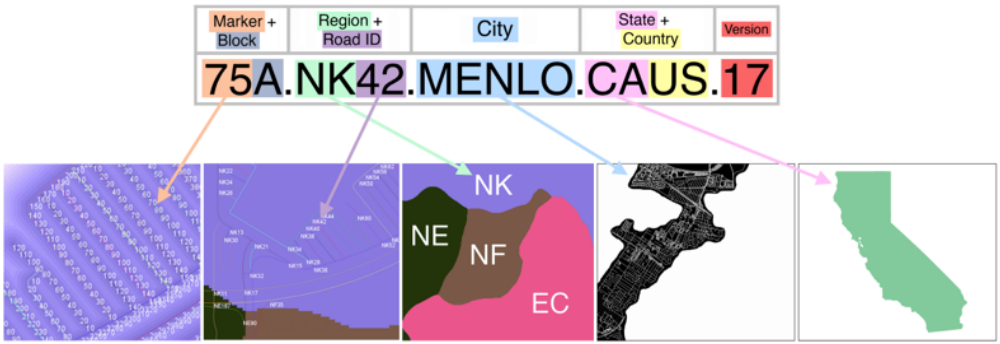
Figure 4. Street Address Format. The hierarchical structure is composed of the country, the state (if applicable), the city, the road name, and the house number of the place, followed by the version year.